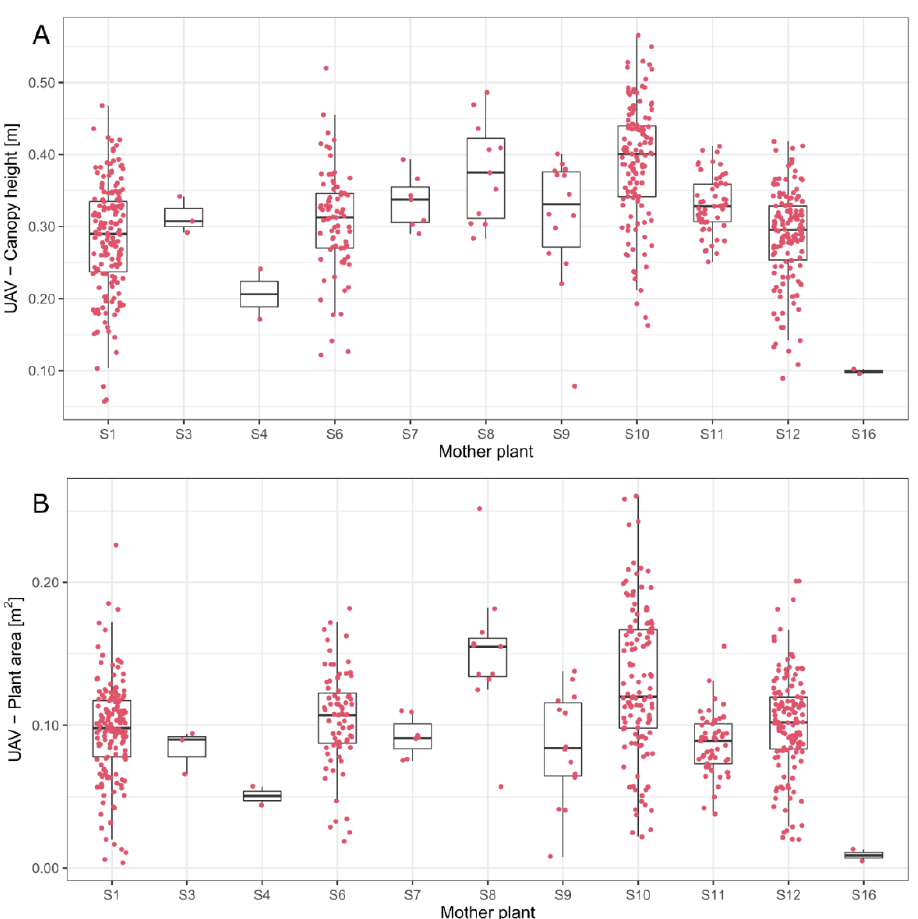
Figure 7. Box plots per mother plant for all Sarcococca plants in SarcoE2 for ( A ) canopy height and ( B ) plant area. Every dot corresponds to an individual plant.